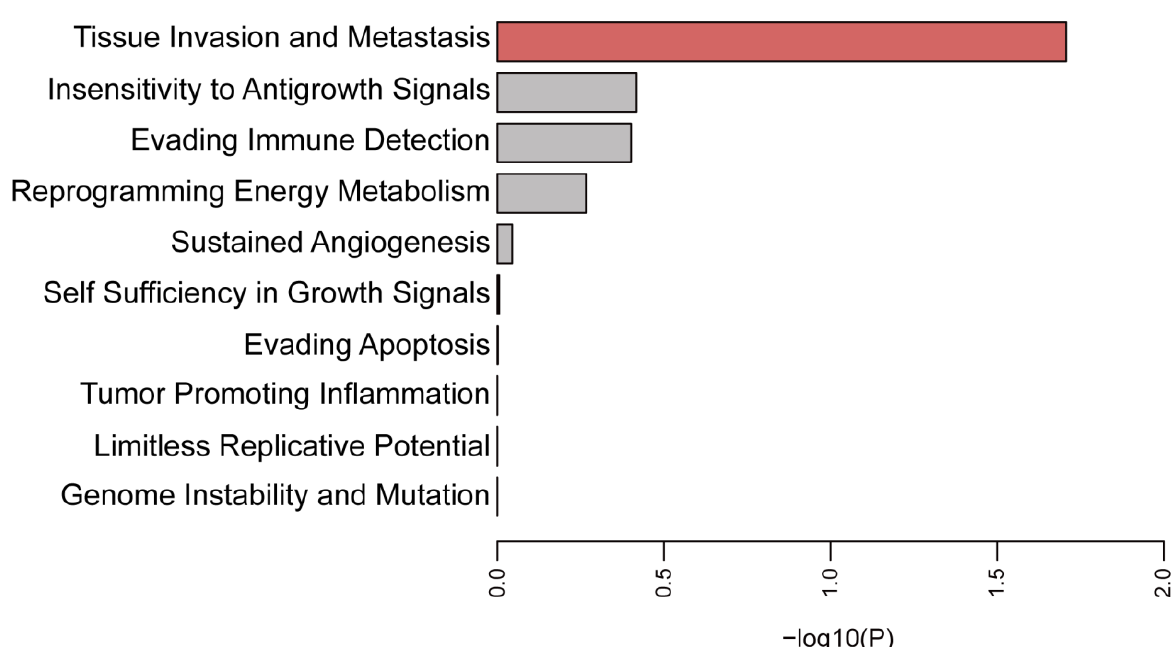
Figure 3. Enrichment analysis of significant high-expression and high-risk genes using the ten can- cer hallmarks. The horizontal axis represents the logarithm of the p value, and the vertical axis represents the terms of the ten cancer hallmarks. p values less than 0.05 were considered statistically significant, indicated by the red color bar.